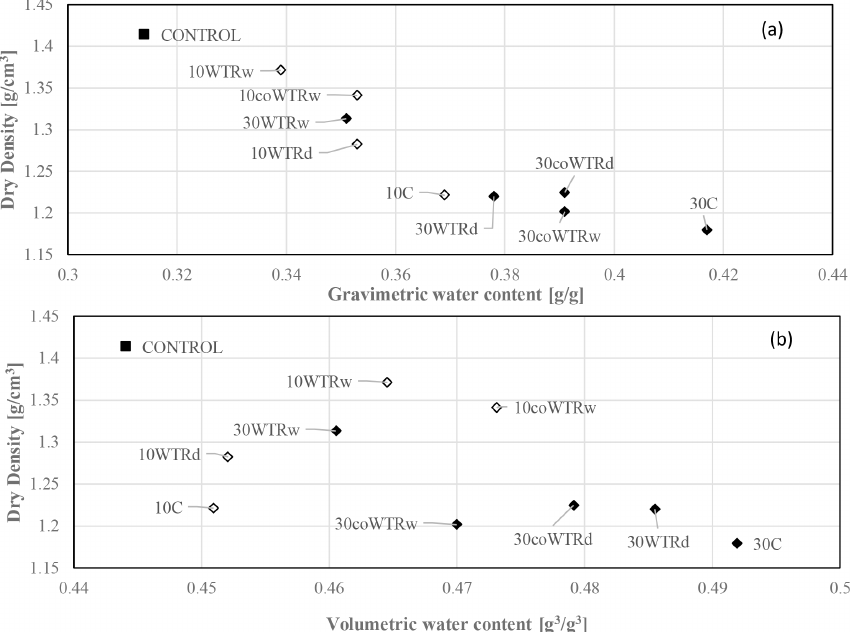
Figure 3. (a) Relationship between dry density and saturated gravimetric water content and (b) relationship between dry density and saturated volumetric water